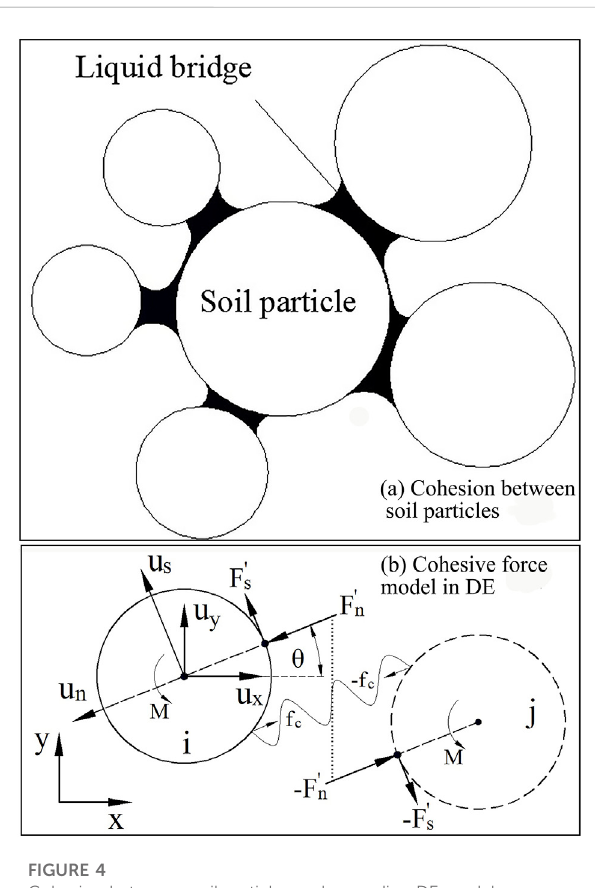
FIGURE 4 Cohesion betweens soil particles and according DE model.